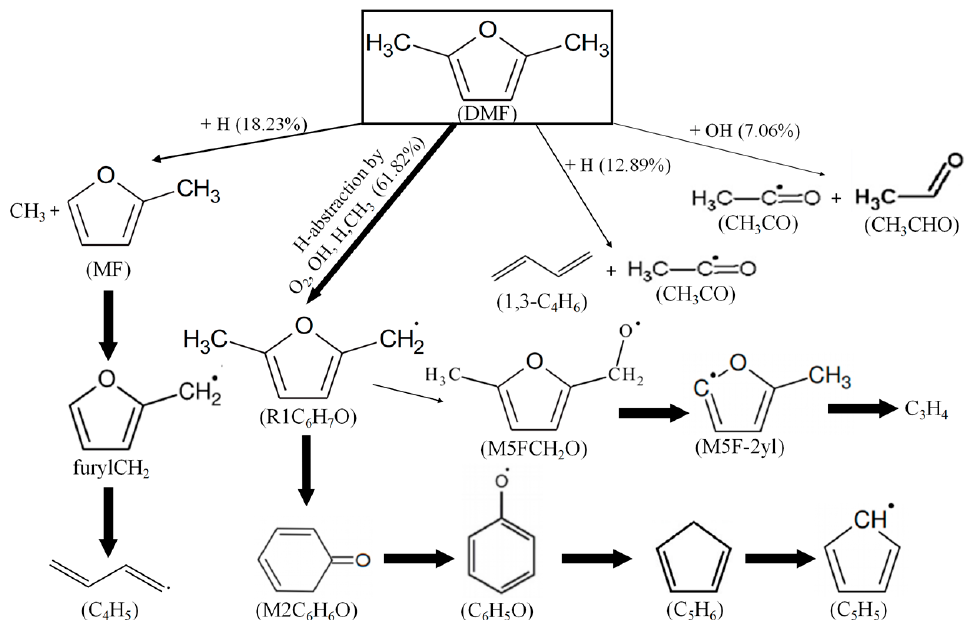
Figure 1. Reaction path analysis for DMF combustion after 20% fuel consumption at 40 bar and 1200 K. The size of the arrows is proportional to the relative rates of consumption of a given species.